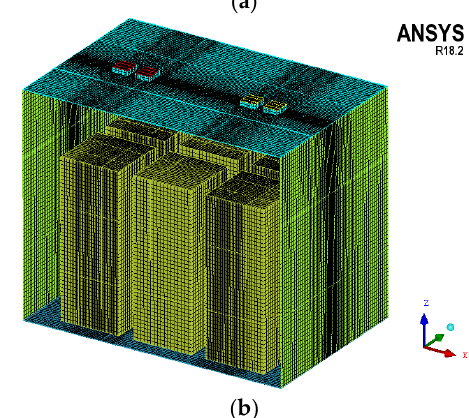
Figure 4. Results of the mesh-independence study: mesh ( a ) independence and ( b ) model.